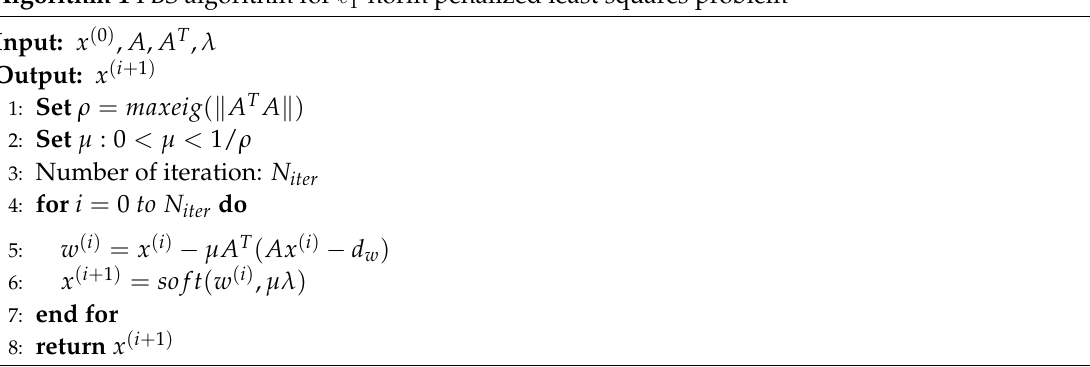
Algorithm 1 FBS algorithm for (cid:96) 1 -norm penalized least squares problem